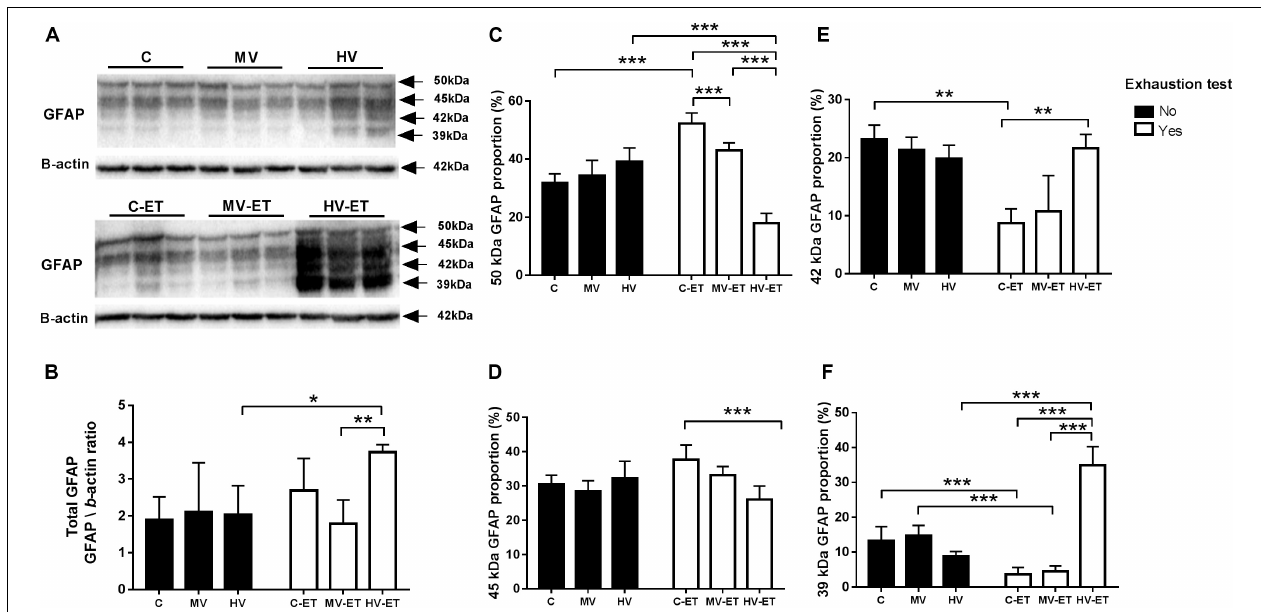
FIGURE 7 | GFAP protein levels assessed by Western blot in the cerebellar tissue. (A) Representative Western blotting membrane of groups without and with exhaustion test. (B) Quantification of total GFAP (sum of the four isoforms): HV-ET vs. MV-ET ( P = 0.004); HV ( P = 0.023). (C–F) : The expression profile of each GFAP isoform. (C) 50 kDa GFAP: HV-ET vs. C-ET; MV-ET; HV ( P < 0.001). C-ET vs. C ( P < 0.001) and MV-ET ( P = 0.013). (D) 45 KDa GFAP: C-ET vs. HV-ET ( P < 0.001) (E) 42 kDa: C-ET vs. C ( P = 0.001); HV-ET ( P = 0.001). (F) 39 kDa GFAP: HV-ET vs. HV;C-ET;MV-ET ( P < 0.001); C vs. C-ET ( P < 0.001). MV vs. MV-ET ( P < 0.001) C, control; C-ET, control + exhaustion test group; MV, moderate-volume group; MV-ET, moderate-volume + exhaustion test group; HV, high-volume group; HV-ET, high-volume + exhaustion test group. * P ≤ 0.05; ** P < 0.01; *** P < 0.001. Values represent mean ± S.D. N = 3 independent experiments per group. All the experiments were carried out in